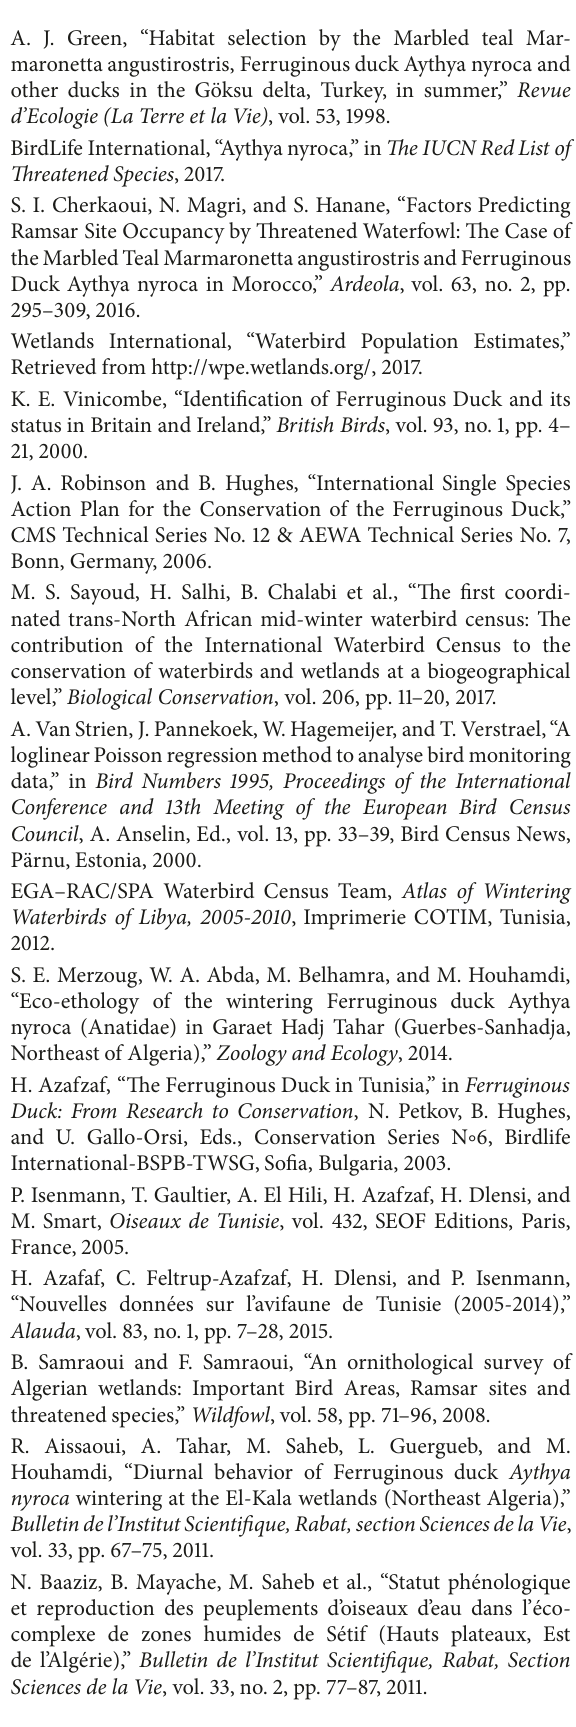
Table S1: national counts of the Ferruginous duck’s wintering individuals per year and per site. (Supplementary